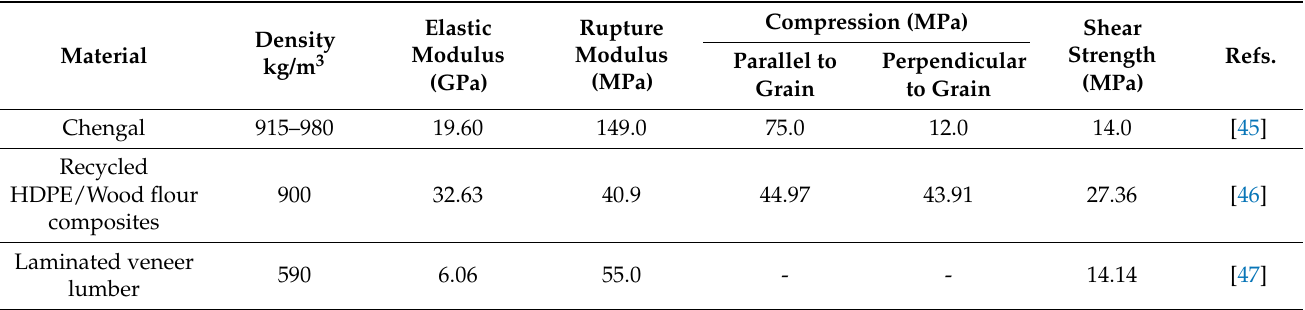
Table 2. Characteristics of Chengal wood in comparison to other wood-based